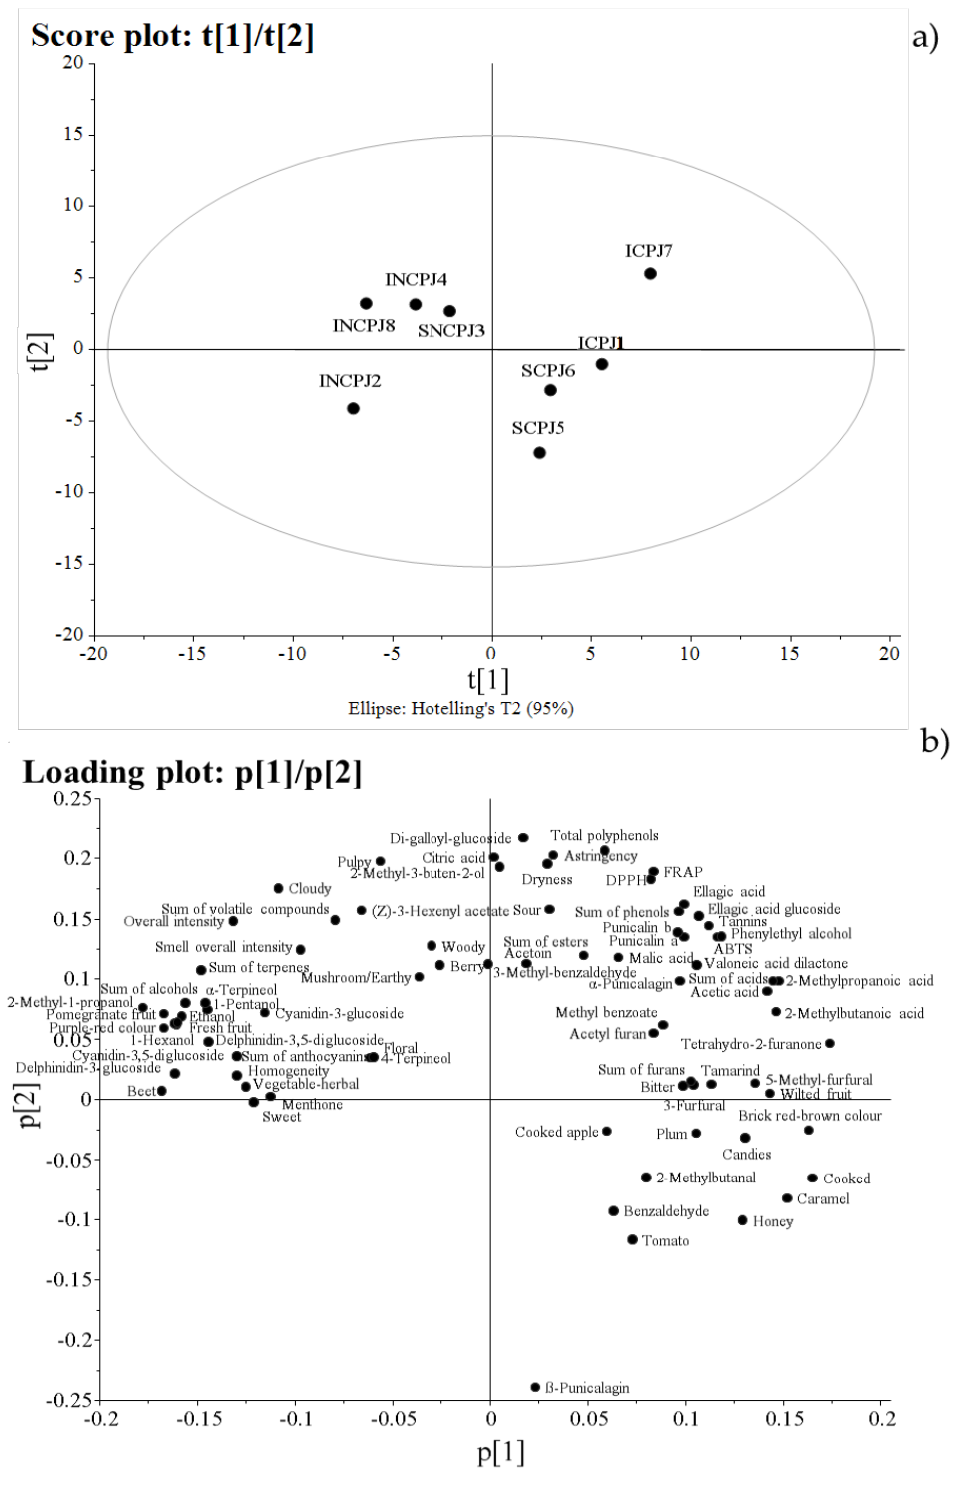
Figure 3. ( a ) Score and ( b ) loading plots of principal component analysis (PCA) model.